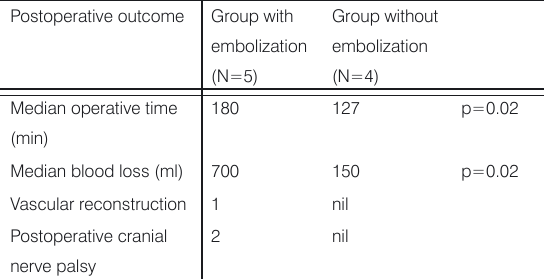
Table 2. Post-operative